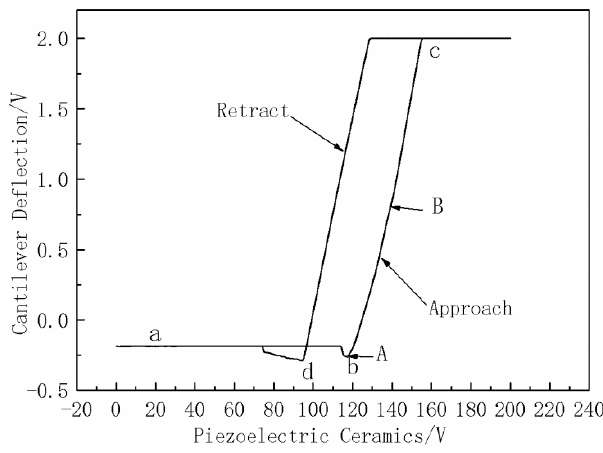
Figure 9. The force curve of prototype.